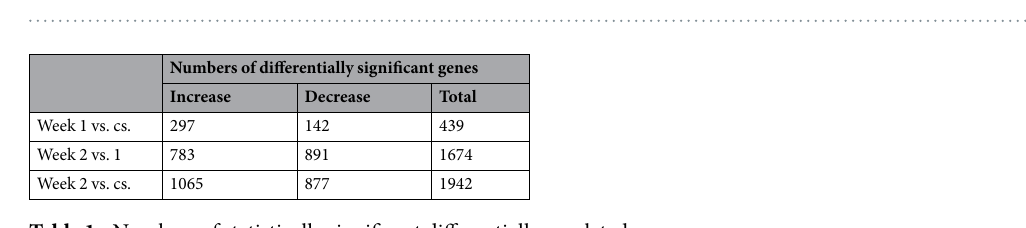
Figure 2. Histological examinations of periosteum of ( a ) control site, ( b ) defect site at week 1 and ( c ) defect site at week 2.